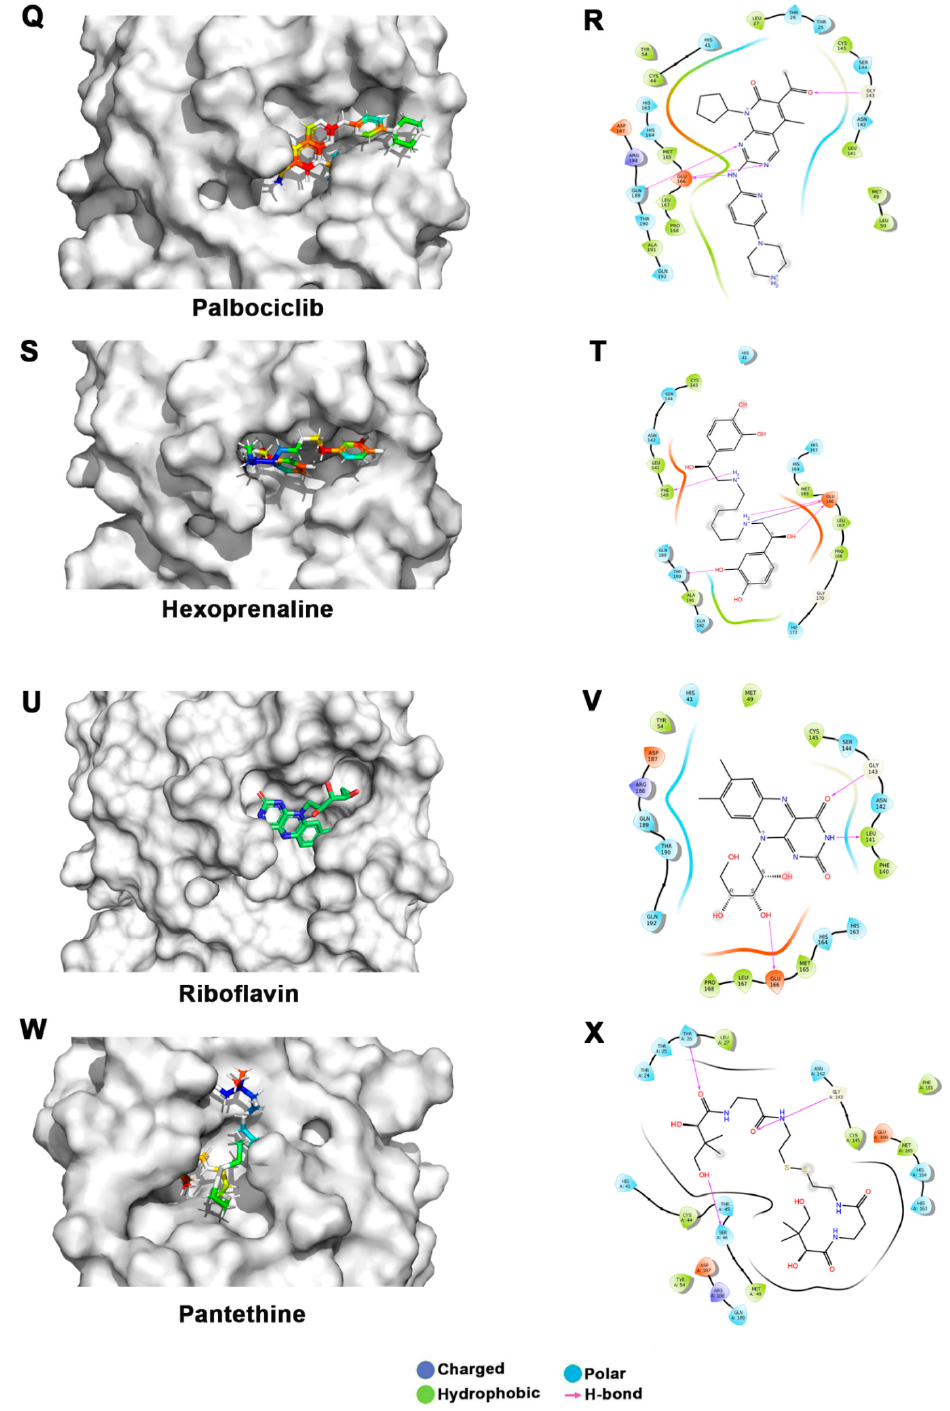
Figure 3. Docking studies of FDA-approved drugs on M pro structures: Docking of FDA-approved drugs (shown in stick representation) ( A ) Iopamidol, ( C ) Mitoxantrone, ( E ) Lumefantrine, ( G ) Dipyridamole, ( I ) Acebutalol, ( K ) Ospemifene, ( M ) Dihydroergotamine, ( O ) Neratinib, ( Q ) Palbociclib, ( S ) Hexoprenaline, ( U ) Riboflavin, and ( W ) Pentethine in the substrate-binding pocket of M pro (Grey surface representation). Carbon, nitrogen, and oxygen are shown in green, blue, and red colors, respectively. ( B ) A 2D inter- action map of drugs, with M pro highlighting various interactions stabilizing protein–drug interactions. ( B ) Iopamidol, ( D ) Mitoxantrone, ( F ) Lumefantrine, ( H ) Dipyridamole, ( J ) Acebutalol, ( L ) Ospemifene, ( N ) Dihydroergotamine, ( P ) Neratinib, ( R ) Palbociclib, ( T ) Hexoprenaline, ( V ) Riboflavin, and ( X ) Pen-